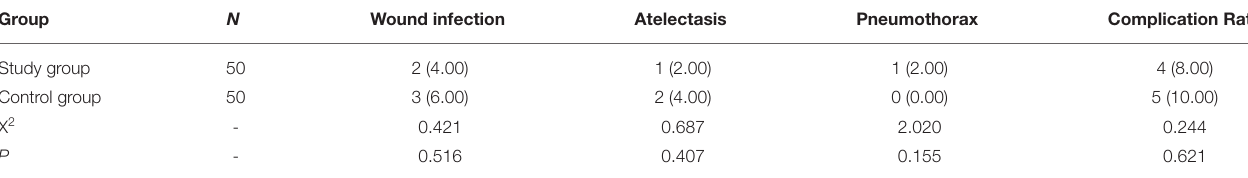
TABLE 6 | Comparison of postoperative complication rate between the two groups [ n (%)]. Group N